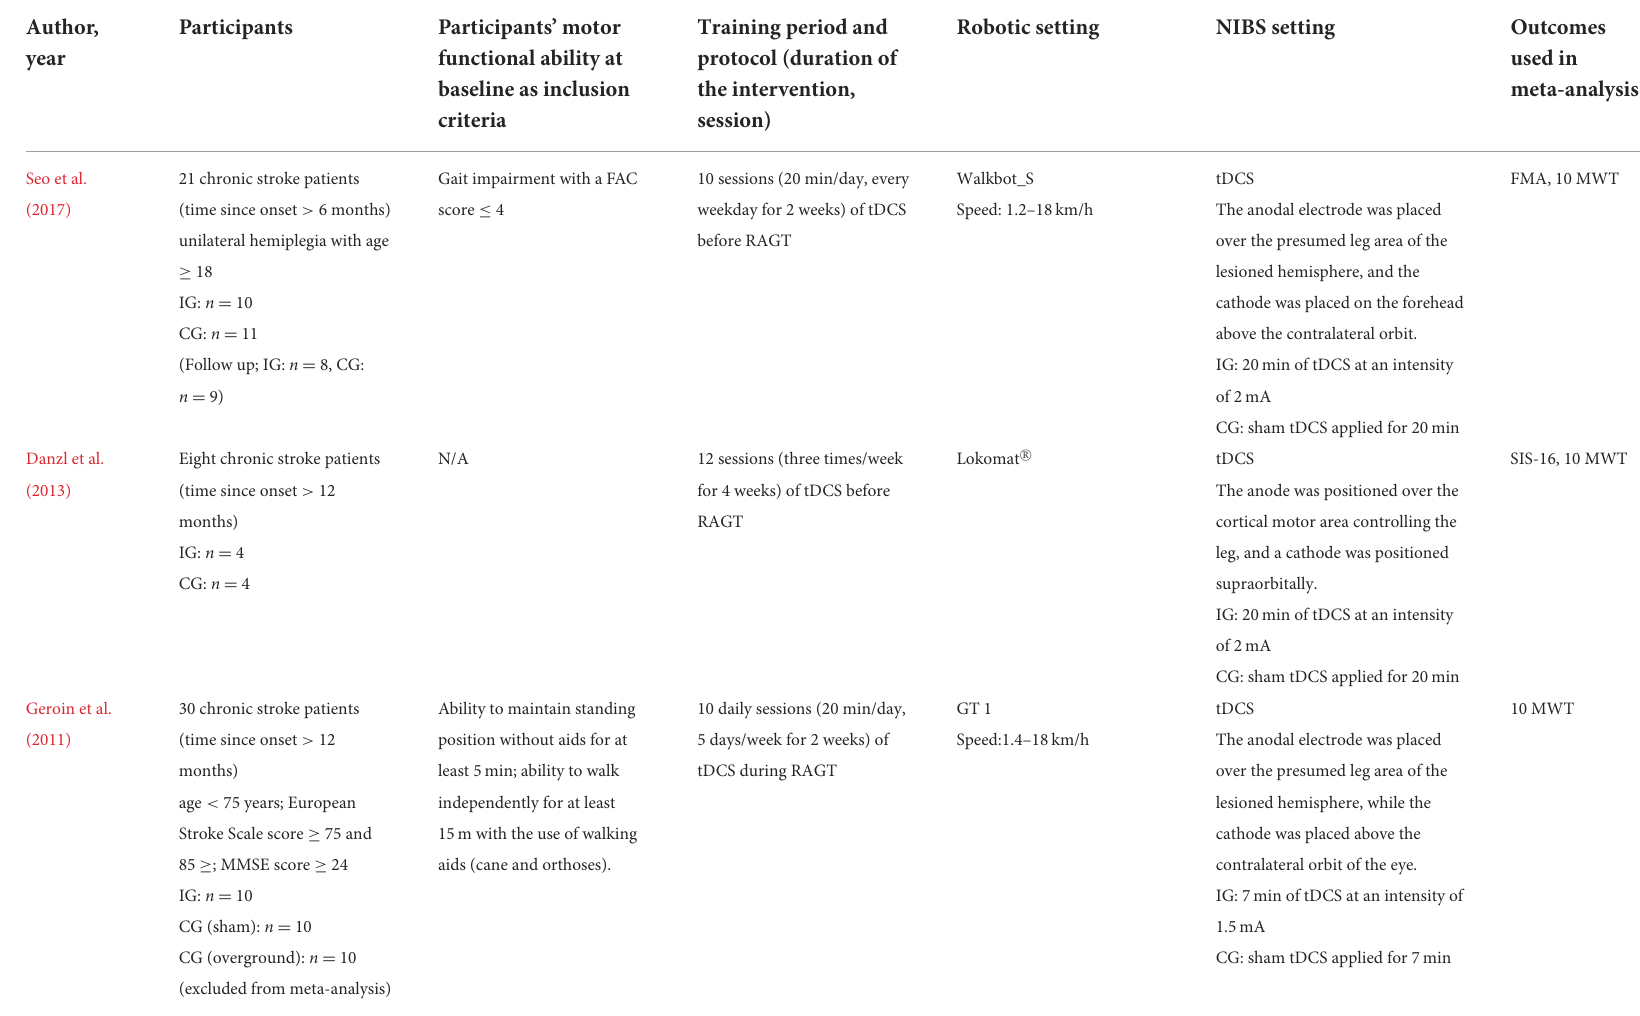
TABLE 1 Characteristics of the included